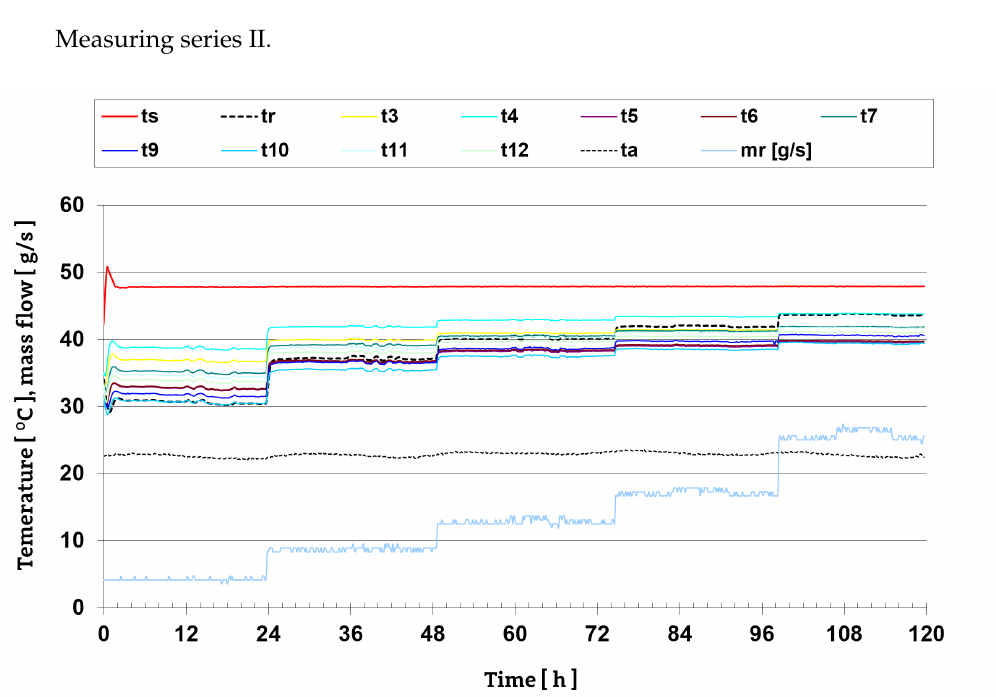
Figure 6. Measuring series II. Measuring series